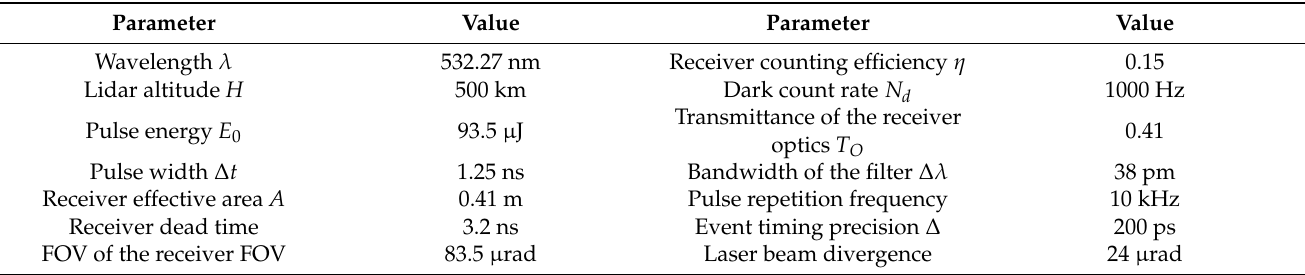
Table 2. Parameters of ICESat-2